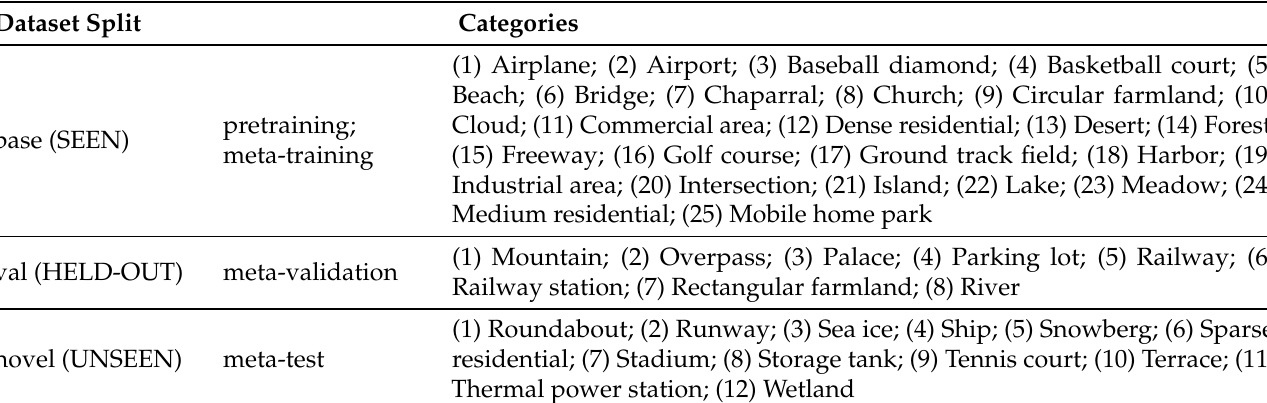
Table 1. NWPU-RESISC45 Dataset split.